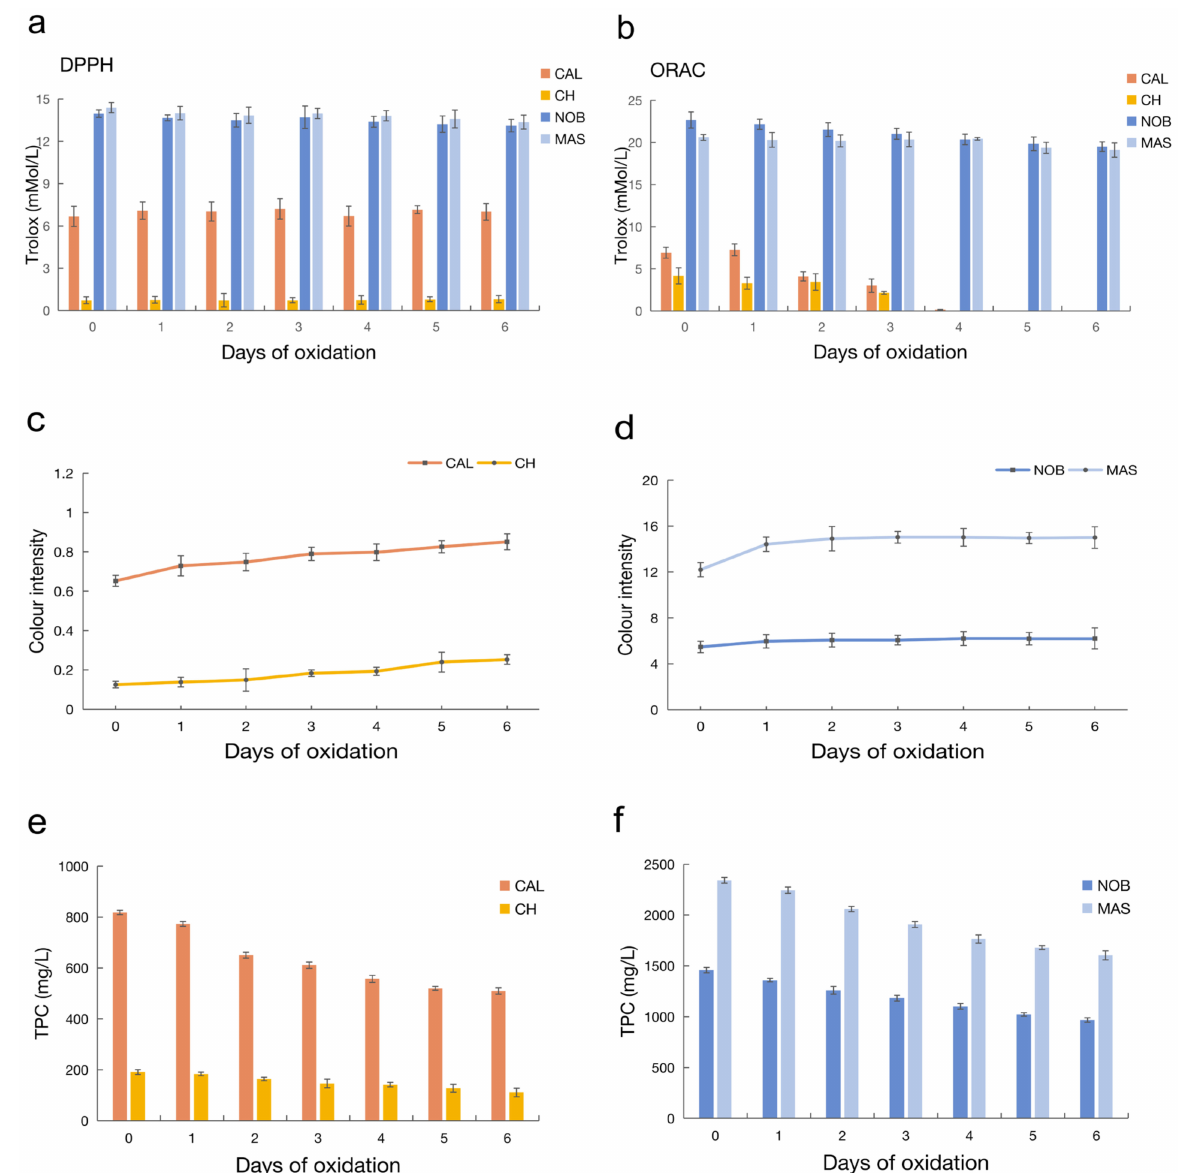
Figure 1. Antioxidant indices, color intensity, and total phenol contents of the wine during oxidation. ( a ) The DPPH of four wine samples during oxidation; ( b ) the ORAC of four wine samples during oxidation; ( c ) color intensity of the CAL and CH wines; ( d ) colour intensity of the NOB and MAS wines; ( e ) the TPC of CAL and CH; and ( f ) the TPC of NOB and